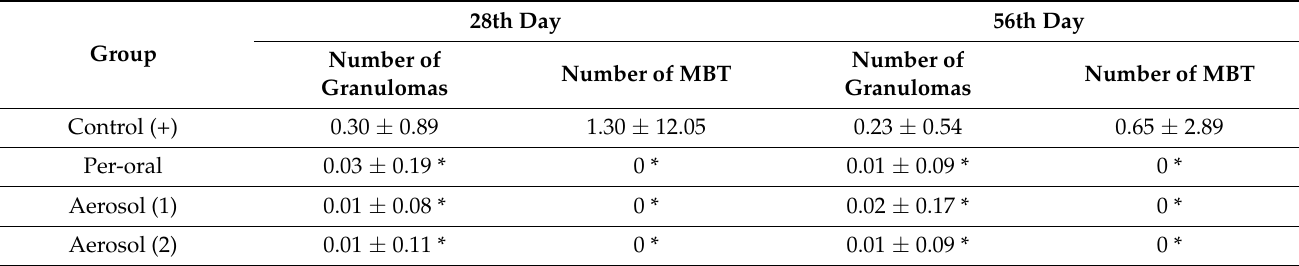
Table 2. Number of granulomas and MBT per visual field in the spleen on the 28th and 56th days after infection (M ± SD), *— p < 0.05 with respect to the Control ( − ) group.